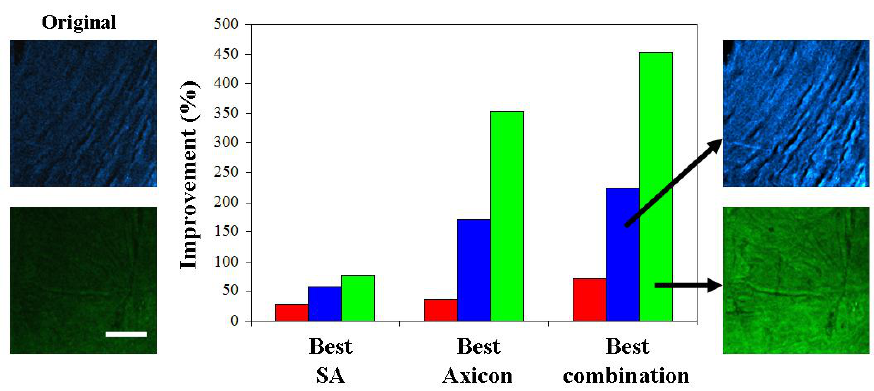
Figure 8. Improvement in MP signal for the samples used herein. Red, blue, and green bars correspond to a piece of cellulose (that of Figure 5), a rabbit cornea ( upper panels ), and an epiretinal membrane ( bottom panels ), respectively. Original images are shown on the ( left ). ( Right ) panels are the improved images for the optimum combinations of SA–axicon.